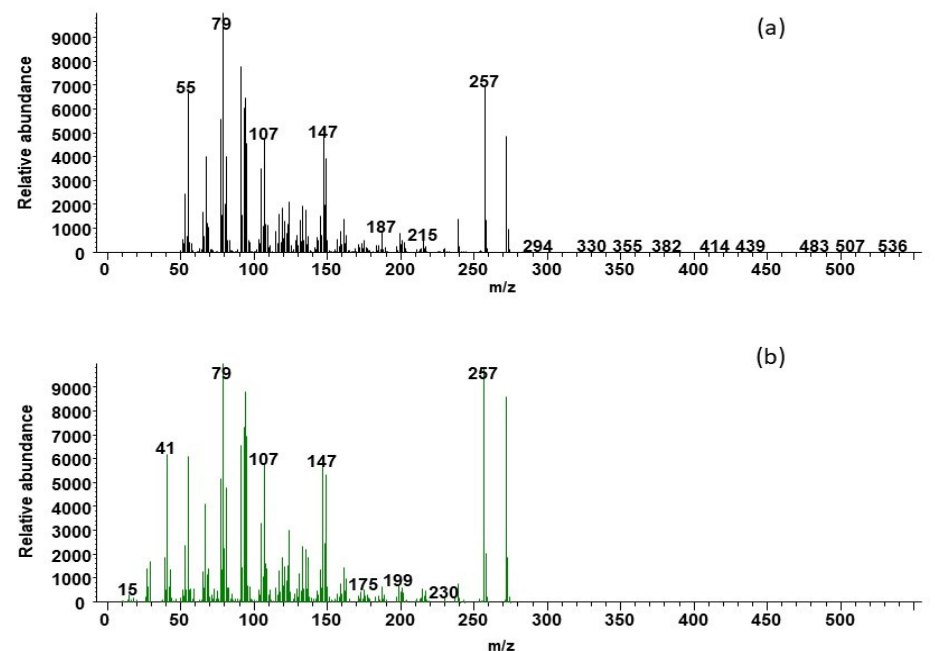
Figure 1. Mass spectra of Androstenone of mouse deer feces ( a ) compared with synthetic androstenone ( b ).